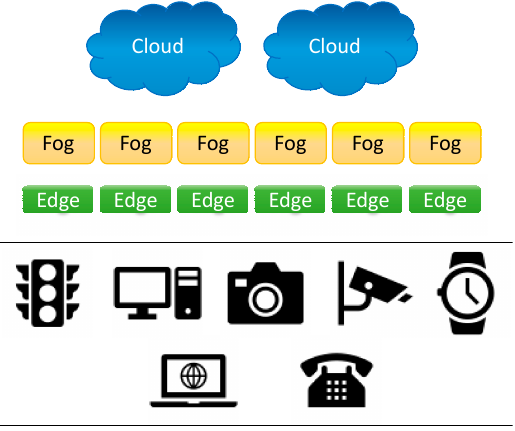
Figure 3. Multi-tier computing networks. The integration of various technologies to achieve intelligent applications and services.